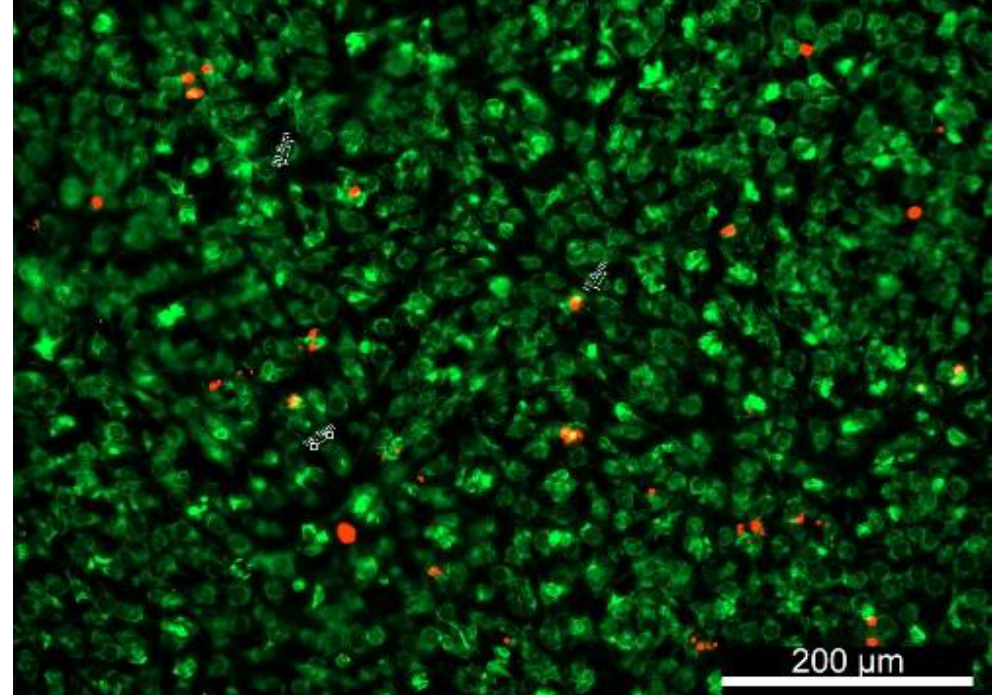
Figure 3. DiOC6(3)- and PI-stained bAChs within the SA – GEL – GA showing that the circular morphology was maintained by the cells at day 45, imaged one day after incubation, magnification 10×.